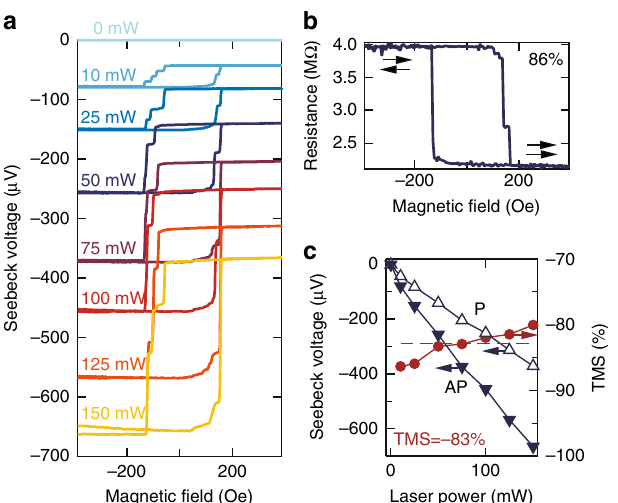
Fig. 3 TMS effect in Co 2 FeAl based MTJs. a Seebeck voltage in dependence on magnetic fi eld for different laser powers. b Major loop of the TMR effect (resistance vs. magnetic fi eld) of the same MTJ without laser heating. c Power dependence of the Seebeck voltage and the TMS ratio extracted from the saturation voltages in a . The average TMS effect of the Co 2 FeAl based MTJs amounts to − power of 150 mW we observe a Seebeck voltage of 15 μ V in the broken MTJ. This remaining signal is probably generated by an in plane temperature gradient in the TiN.